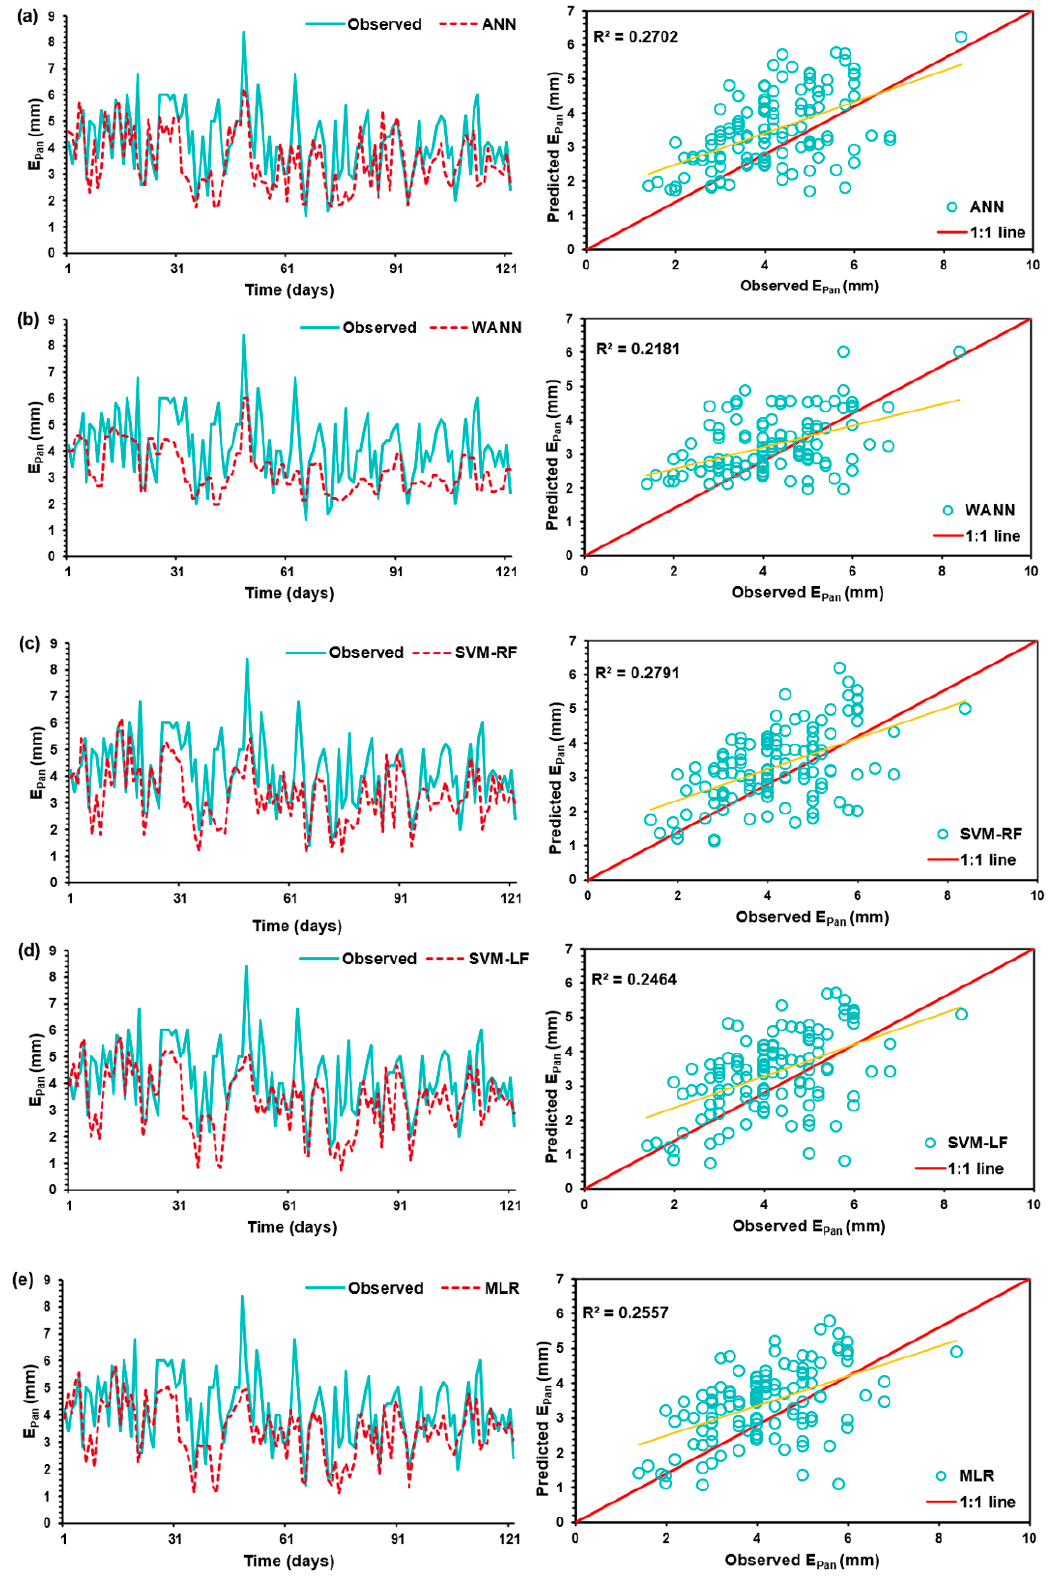
Figure 8. Line and scatter plot between observed and predicted data at scenario 3 for ( a ) ANN, ( b ) WANN ( c ) SVM-RF, ( d ) SVM-LF, and ( e ) MLR, for the study area.